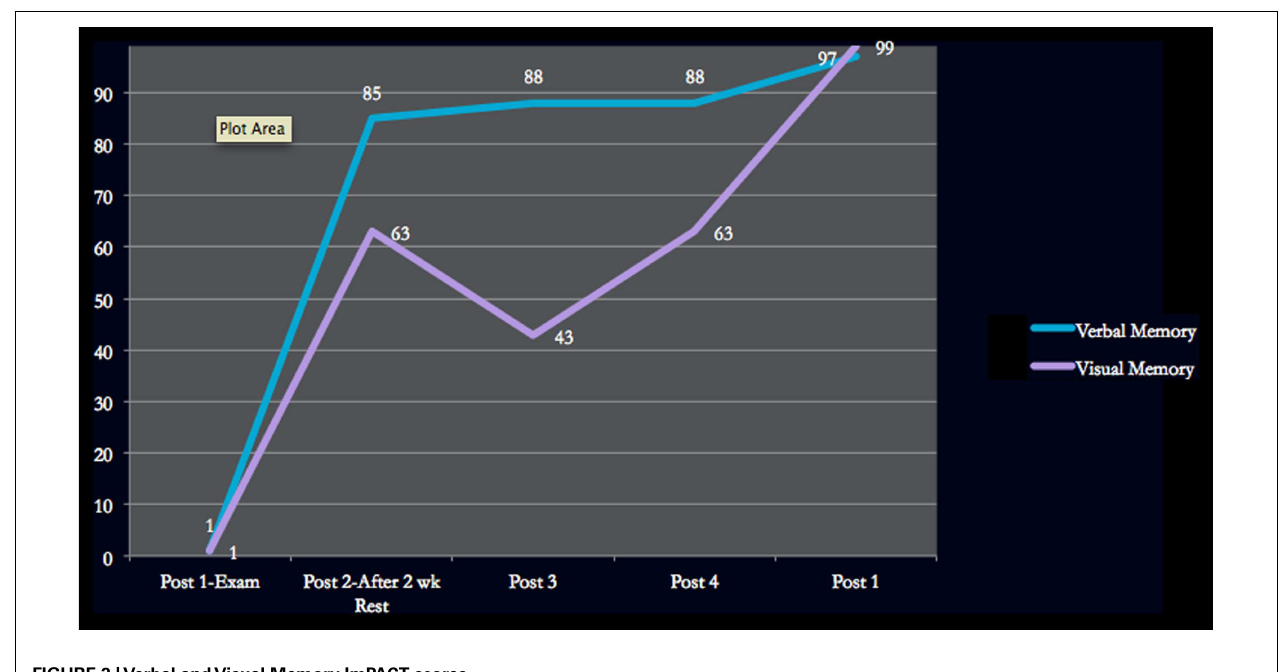
FIGURE 2 |Verbal andVisual Memory ImPACT scores.